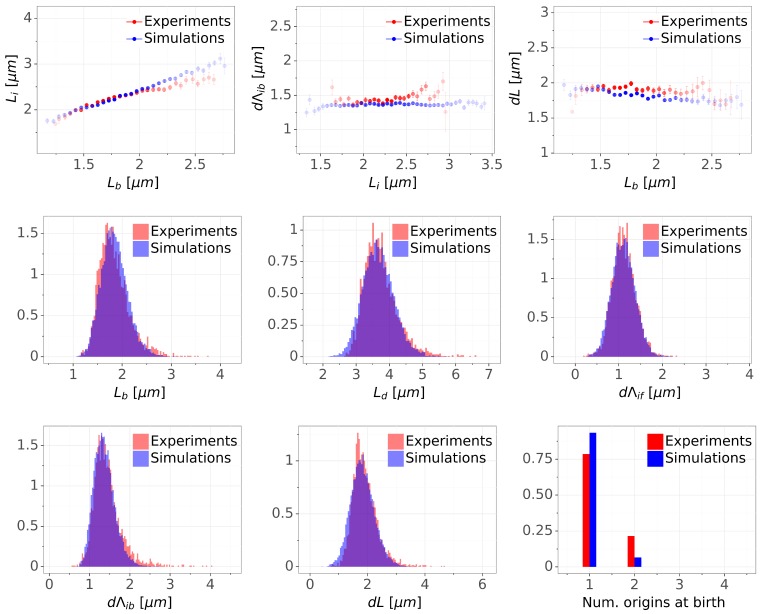
Detailed comparisons of cell cycle variables distributions and correlations between experiments and simulations for M9+glycerol condition (with automated origin tracking).The top row shows binned scatter plots of pairs of variables. The transparency degree reflects the density of data on the horizontal axis. Note that the slight slope of the adder plot (d⁢L⁢v⁢s.Lb) can be corrected when reducing the variances of the division adder distribution (data not shown). As the initiation measurement is made imprecise for experimental (e.g. acquisition rate) and biological (e.g. variable cohesion of origins), it is reasonable to assume that we overestimate the variance of that parameter.